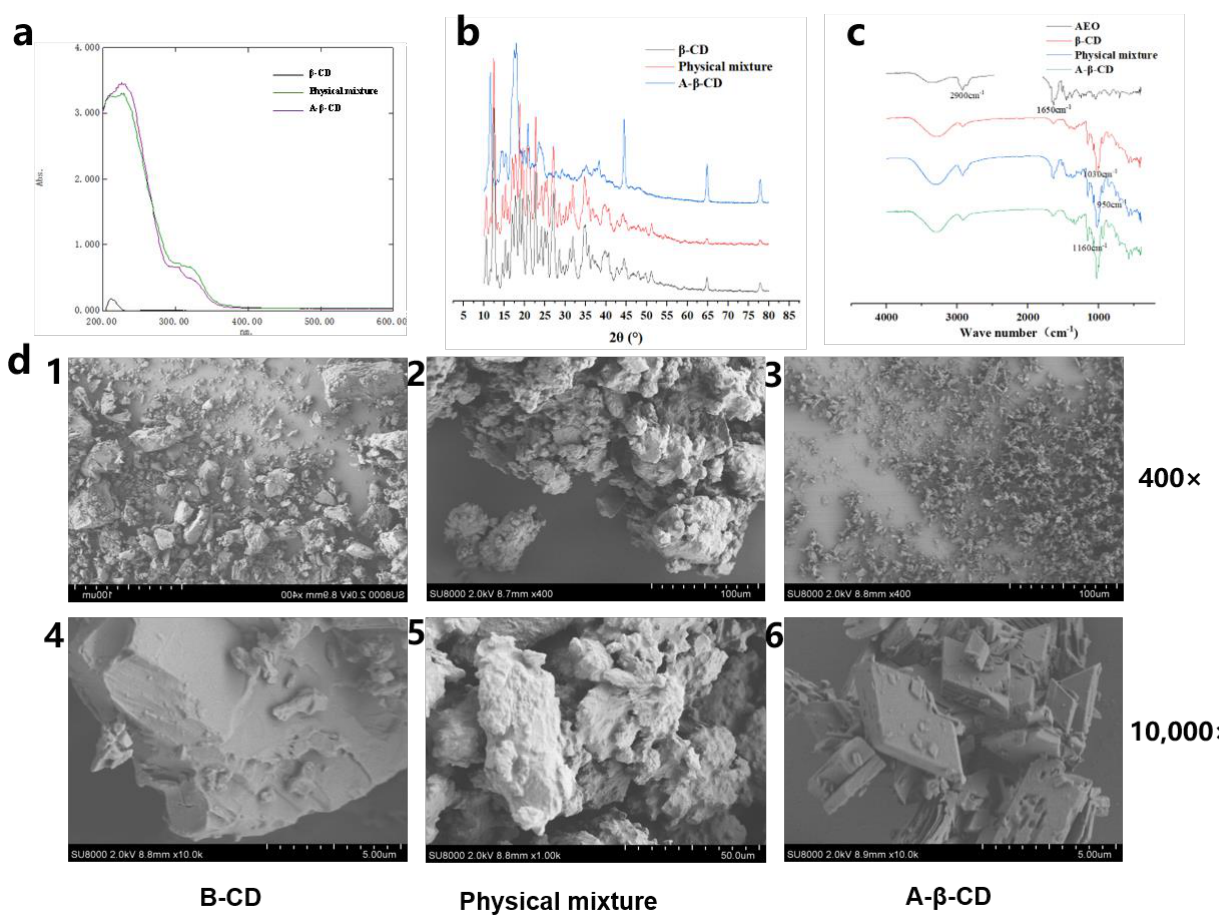
Figure 4. Characterization of a − β − CD. ( a ) UV absorption spectrum; ( b ) FT − IR spectroscopy; ( c ) X − ray powder diffraction; ( d ) scanning electron microscopy: 1. β − CD 400 × ; 2. physical mixture 400 × ; 3. A − β − CD 400 × ; 4. β − CD 10,000 × ; 5. physical mixture 10,000 × ; 6. A − β − CD 10,000 × .